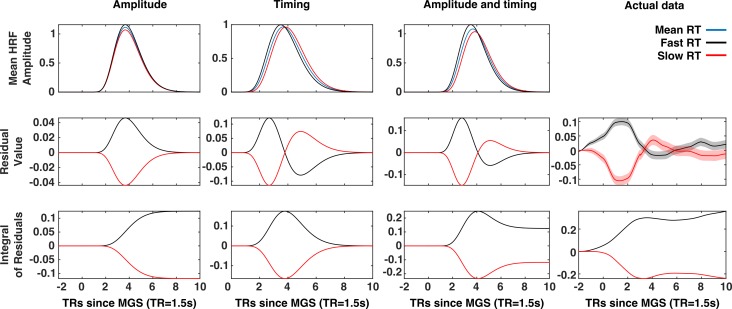
A comparison of timing and amplitude effects on brain state expression.The x-axis of each panel represents time (in 1.5 s TRs) relative to the execution of the memory-guided saccade. An amplitude relationship (First column), a timing relationship (second column), and a combined amplitude and timing relationship (third column), are compared to actual data (fourth column). The first row depicts the patterns of trial-to-trial BOLD signal variability for each mechanism. Trials are divided into fast (black) and slow reaction time (red) sets defined by a median split. The average BOLD signal across all trials depicted in blue. The average residuals time series (second row) for fast and slow trials exhibit distinct patterns for each possible mechanism. The time integral of the average residuals makes this difference explicit: If a trial-to-trial relationship between the VME brain state and reaction time simply reflected trial-to-trial variability in the latency of the eye-movement and eye-movement evoked visual activity, then the integrals of the residual time series for fast and slow reaction time trials should both converge to zero (second column). However, the absence of this convergence in the mean VME brain state data (fourth column) is consistent with either an amplitude-based relationship or a mix of amplitude and latency. Where present, red and black envelopes represent ±1 SE of the mean.